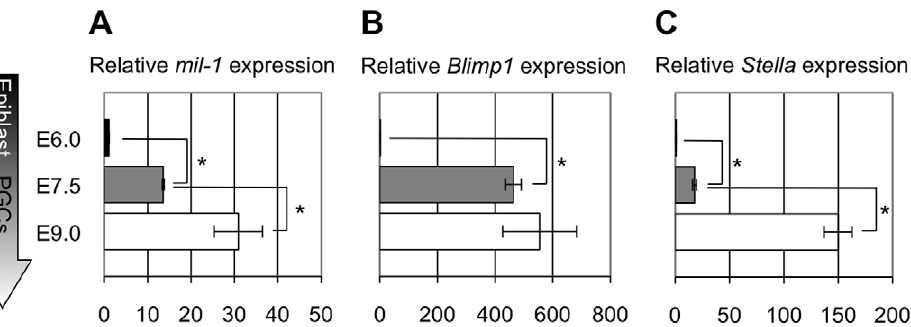
Figure 2. The expression of mil-1 , Blimp1 , and Stella become upregulated during PGC development. (A, B, C) Quantitative RT-PCR analysis of the expression of (A) mil-1 , (B) Blimp1 , and (C) Stella was performed using epiblasts (E6.0) and PGCs (E7.5 and E9.0). Histograms represent relative expression levels of these three genes at each developmental stage. The averages of expression levels in the epiblasts (E6.0) were set as 1.0. Gapdh PCR signal was used as an internal control to measure relative. The data were obtained from three individual embryos. *p , 0.05. Error bars represent SEM.